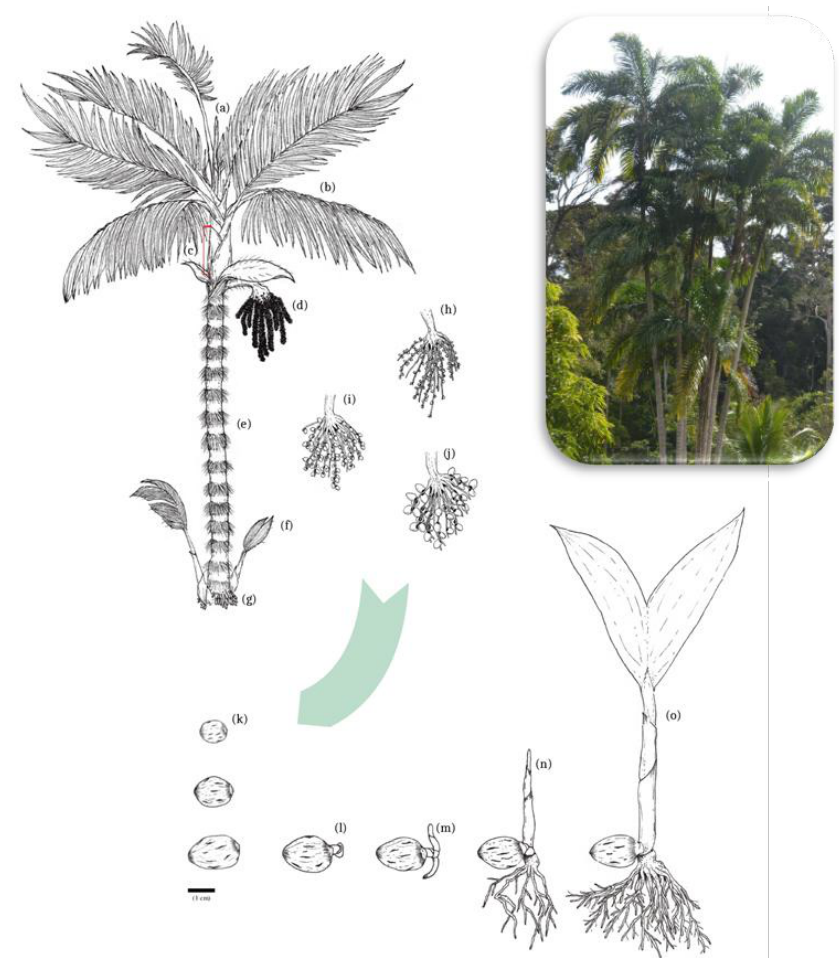
Figure 2. General morphology of B. gasipaes and germination. On the right, a Peach palm near to an ombrophilous dense forest in Altamira, Para, Brazil, followed by a representation of an adult individual and different fruits sizes. The arrow indicates different seed sizes and the germination morphology, adapted from Silva et al. [24]. Legends: (a) apical gem; (b) pinnate leaves; (c) palm heart; (d) inflorescences; (e) internode with spines; (f) shoots; (g) roots; (h–j) different sizes of fruits; (k) seeds; (l) non-differentiated cell mass; (m) radicular and caulinar primordium; (n) eophyll elongation; (o) bifid primary